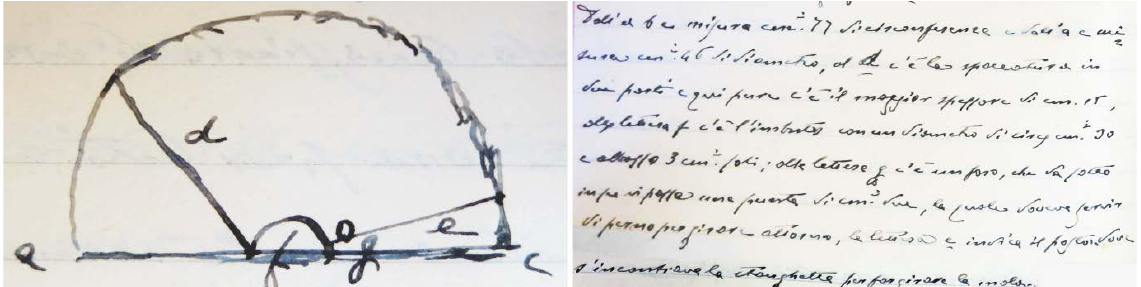
Figure 6. Original drawing and description of the Olynthus mill from San Donato in Tiziani’s manuscript (Tiziani 1900: